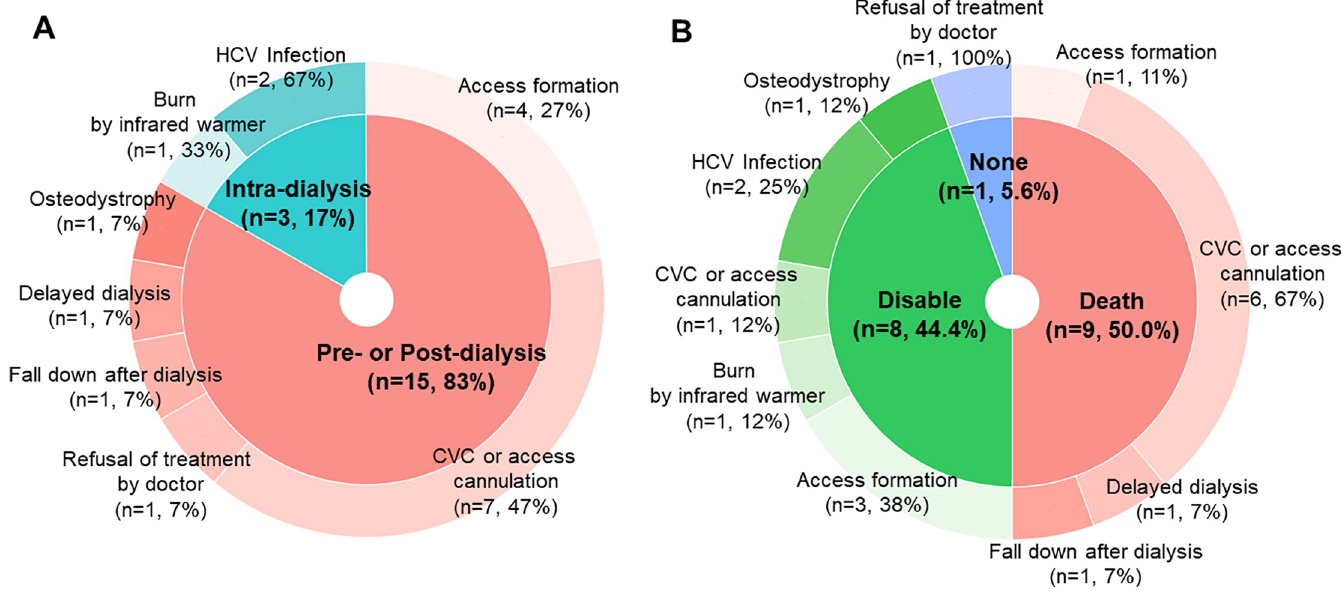
Fig 2. Characteristics of malpractice recognized by the court. A. Temporal characteristics according to clinical characteristics of malpractice. B. Grave outcomes according to clinical characteristics of malpractices. The percentages in pie chart represent proportions in whole malpractices and the percentages in donut chart represent sub-proportions in each pie